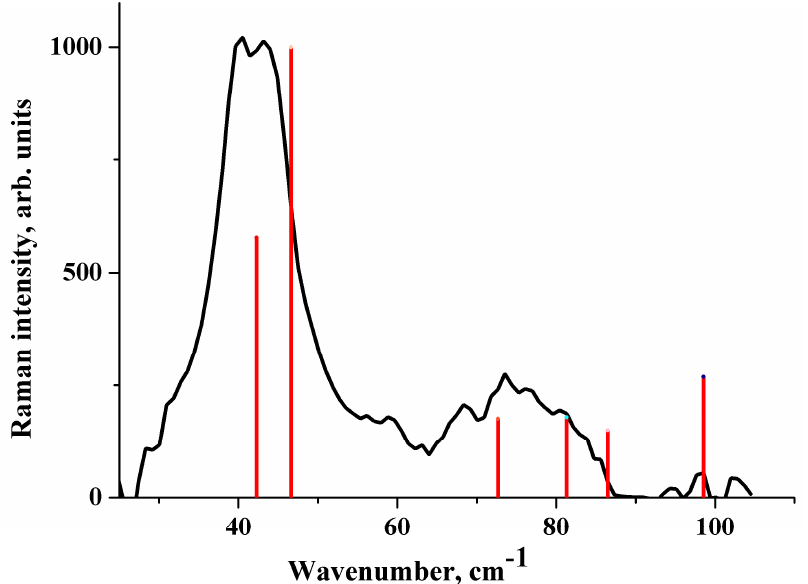
Figure 5. Raman spectrum of the CRB crystal in the region of 25–100 cm − 1 (see text). Experiment (black line) vs. B3LYP(AtomOnly) computations (red bars). The height of the bars is proportional to the relative Raman intensity of the corresponding transition.